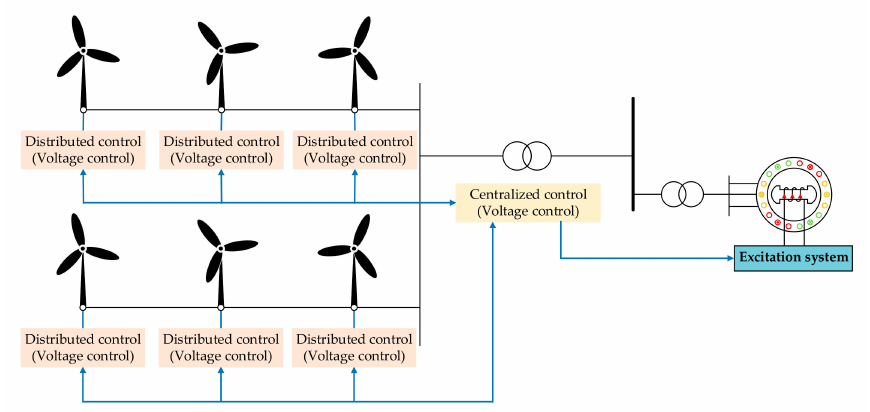
Figure 11. Wind farm information transmission